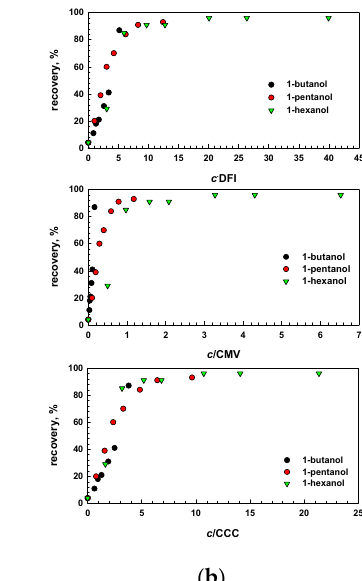
Figure 16. Flotation recovery of coal as a function of ( a ) frother concentration expressed in M; and ( b ) products of c ·DFI, c /CMV and c /CCC (data of recovery and DFI from [9]).